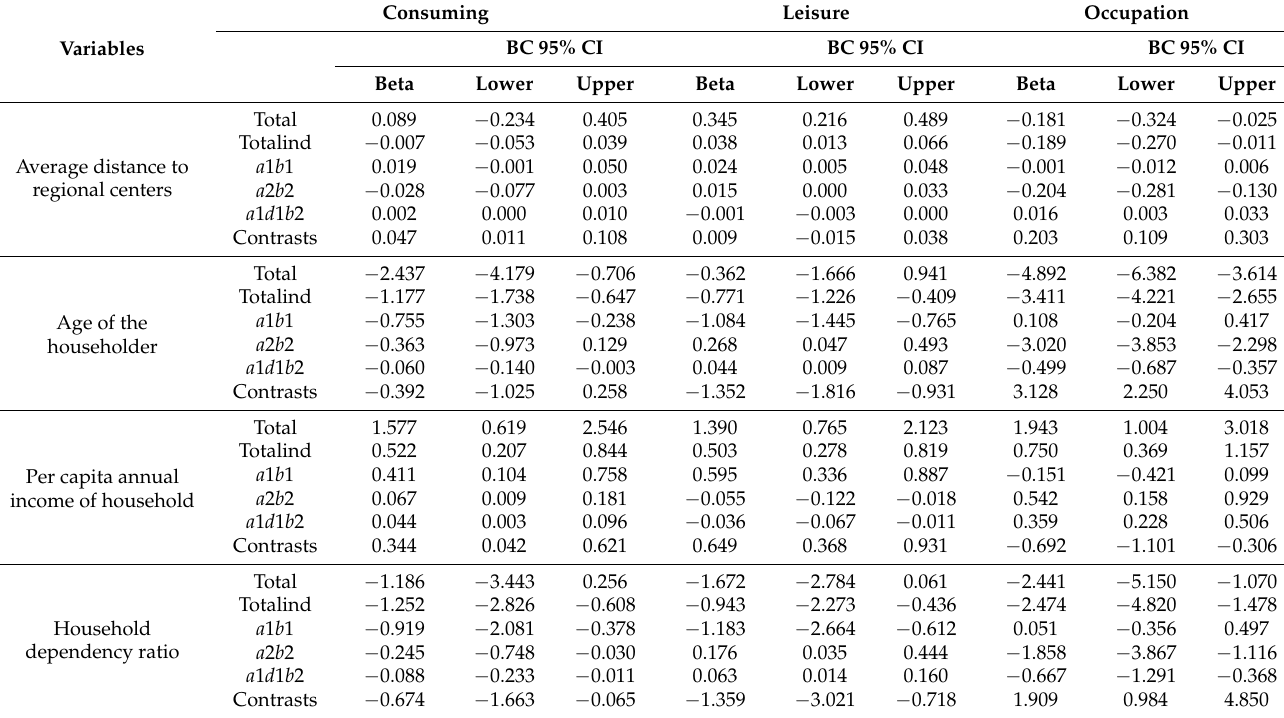
Table 6. Results of multiple mediation analysis of the relation between household characteristics, livelihood and accessibility of rural consuming, leisure, and occupation